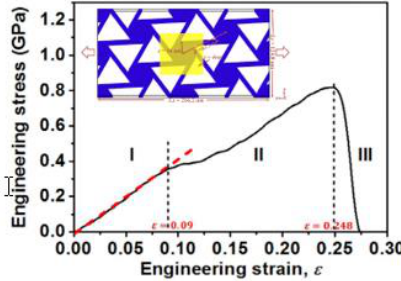
Figure 7. The molecular dynamics (MD) simulation results of an engineering stress – strain curve of the MG-based chiral nanolattice structures, showing a large elastic strain of about 9%, where the inset schematic diagram shows the design of the chiral lattice structure. Adapted from [89] with copyright permission from Elsevier, 2017.